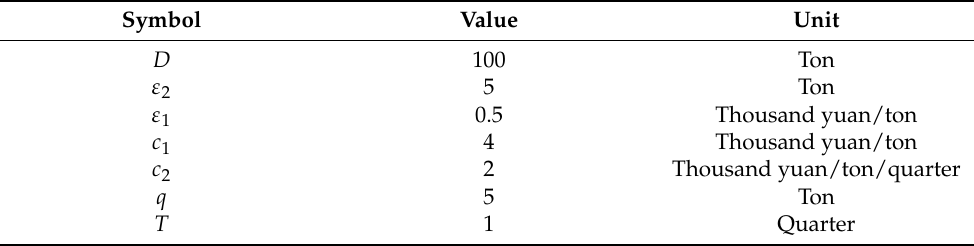
Figure 1. The effect of the predicted values of refined oil price on optimal sales incentives, production quantity, and the expected profits. Table 2. The parametric values of the sequential optimization decision model when the predicted values of refined oil price are